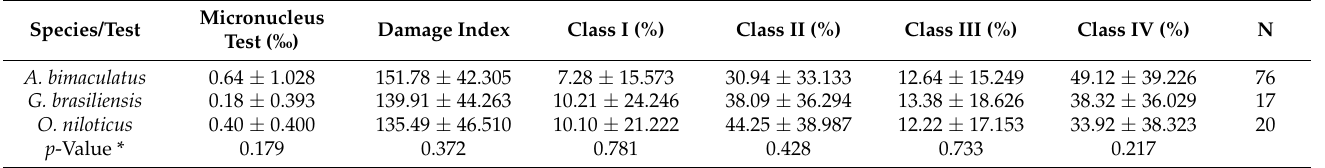
Table 4. Micronucleus test and DNA damage index assessed by comet assay for all studied species (mean ±